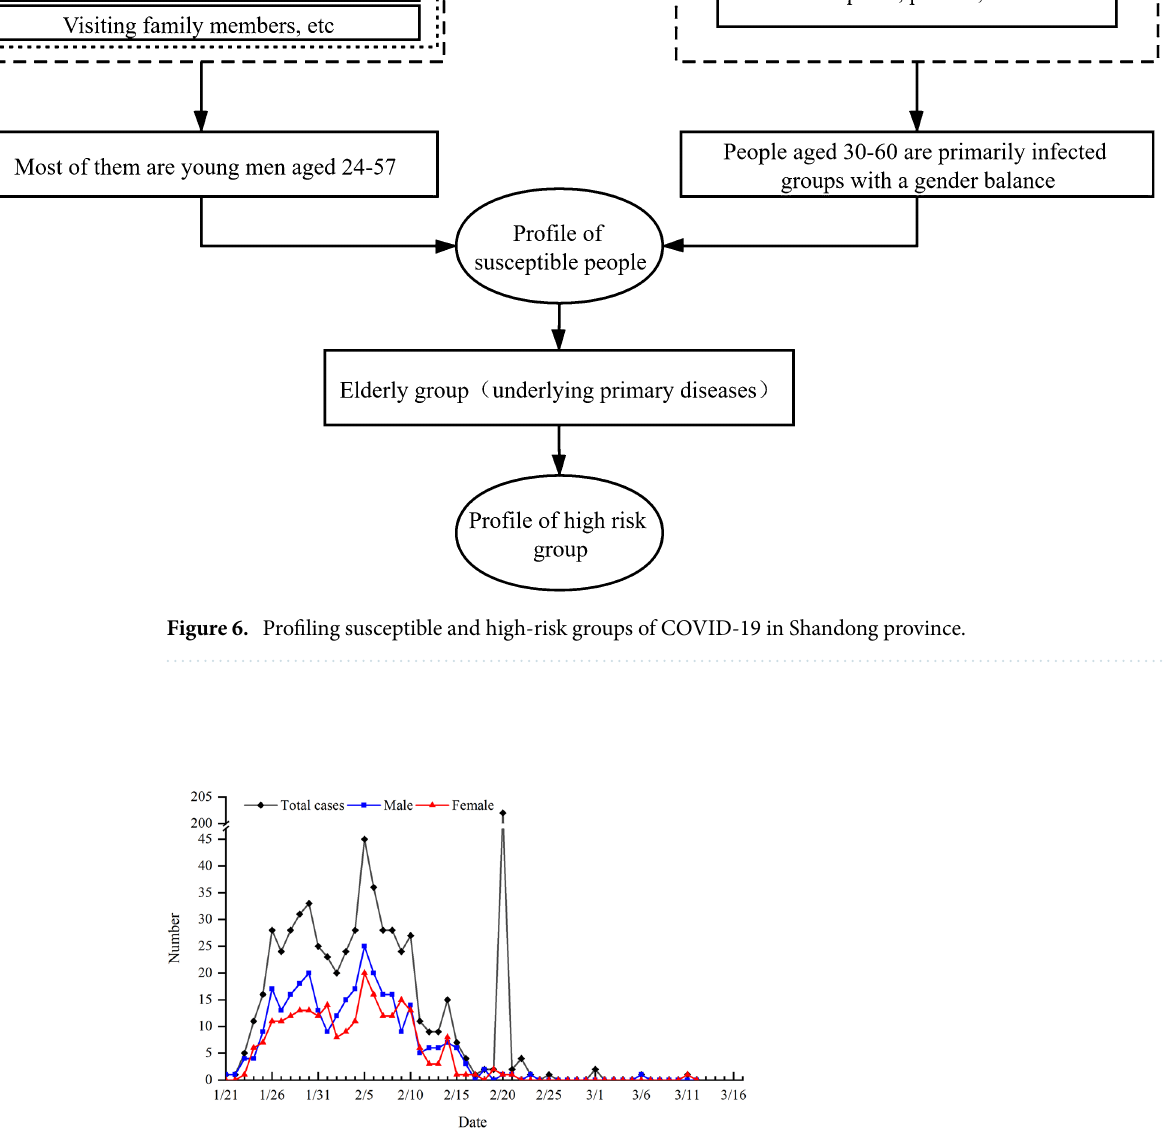
Spatial pattern. Overall spatial distribution at city‑level. According to the spatial distribution map of Ji’nan, Yantai and Weifang, with 61, 49, 47, 47 and 44 cases respectively, but no confirmed cases were reported in Dongying. There was a significant correlation between the number of confirmed cases and the level of economic development, population size and the number of areas moved in (Table 2).